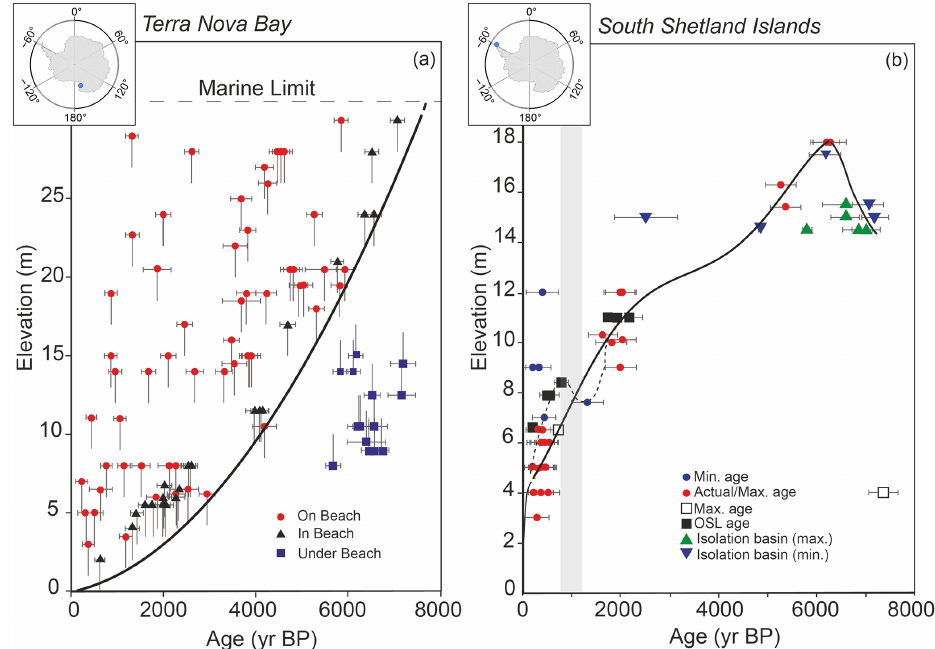
Figure 4. Two patterns of RSL change in Antarctica. (a) Many curves show a typical exponential shape, as represented by the curve from Terra Nova Bay, Ross Sea region (Baroni and Hall, 2004, recalculated with marine reservoir correction of Hall et al., 2010, updated for Marine20 calibration dataset). (b) A more complex pattern as represented by the South Shetland Islands. This curve is thought to show evidence of two possible transgressions ( ∼ 6.5–7ka and dashed line), linked to glacier advance (e.g. Hall, 2010; Watcham et al., 2011; Simms et al., 2012). Redrawn from curves of Hall (2010), Simms et al. (2011), and Watcham et al. (2011), with ages recalculated with Marine20 and IntCal20. Circles denote radiocarbon samples from raised beaches (Hall, 2010 and references therein), squares are OSL dates of beach cobbles (Simms et al., 2011), and triangles are dates of the marine–freshwater transitions in isolation basins (Mäusbacher et al., 1989; Martinez-Macchiavello et al., 1996; Watcham et al., 2011). The shaded vertical bar indicates the possible period of glacier readvance associated with the dashed